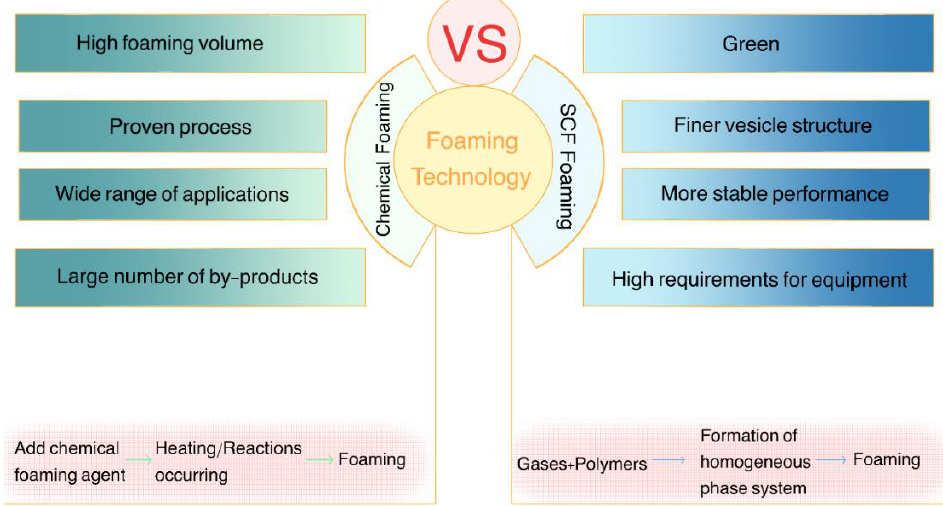
Figure 2. Comparison of supercritical foaming technology and chemical foaming technology.